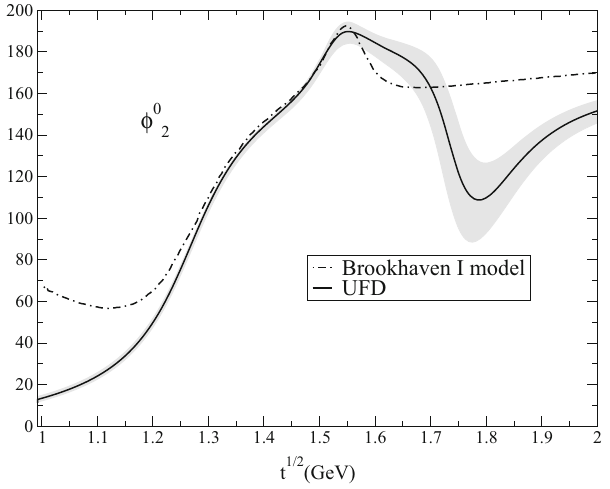
Fig. 3 Comparison between the UFD g 0 phase and the one obtained 2 with the Brookhaven-I model. Note that the latter violates Watson’s Theorem at K ¯ K threshold. Also, the former includes an f 0 ( 1810 ) res- onance whereas the latter uses a flat background. As explained in the text, the latter is strongly disfavored when fitting Brookhaven II data on the